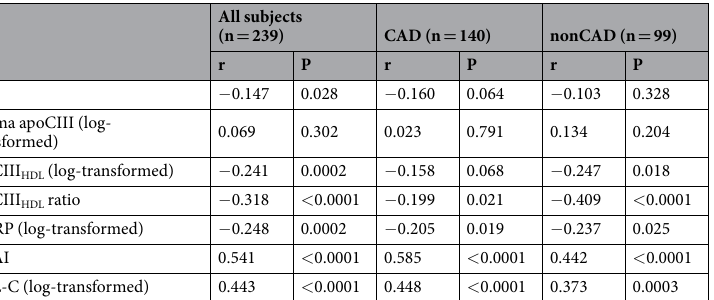
Table 5. Pearson’s correlation analyses between HDL-mediated cholesterol efflux capacity and clinical and biochemical parameters. CAD indicates coronary artery disease; BMI, body mass index; apoCIII, apolipoprotein CIII; hsCRP, high sensitivity C reactive protein; apoAI, apolipoprotein AI; HDL-C, high-density